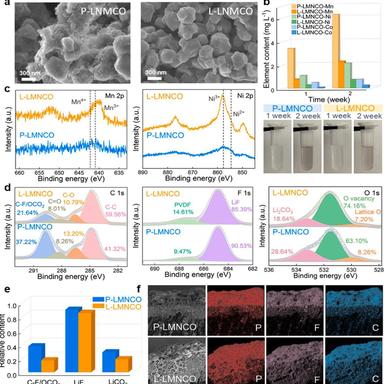
Morphological and chemical environmental characterizations of the cycled P-LMNCO and L-LMNCO cathodes. (a) SEM images for the cycled cathodes after 400 cycles at 1C; (b) content histogram of the TM elements dissolved from P-LMNCO and L-LMNCO powders soaked in liquid electrolytes; (c,d) XPS spectra of TM elements and (e) by-products at the surfaces of the cycled cathodes after 200 cycles; (f) cross-sectional images and corresponding EDS mapping of Li anode in the cycled cells.